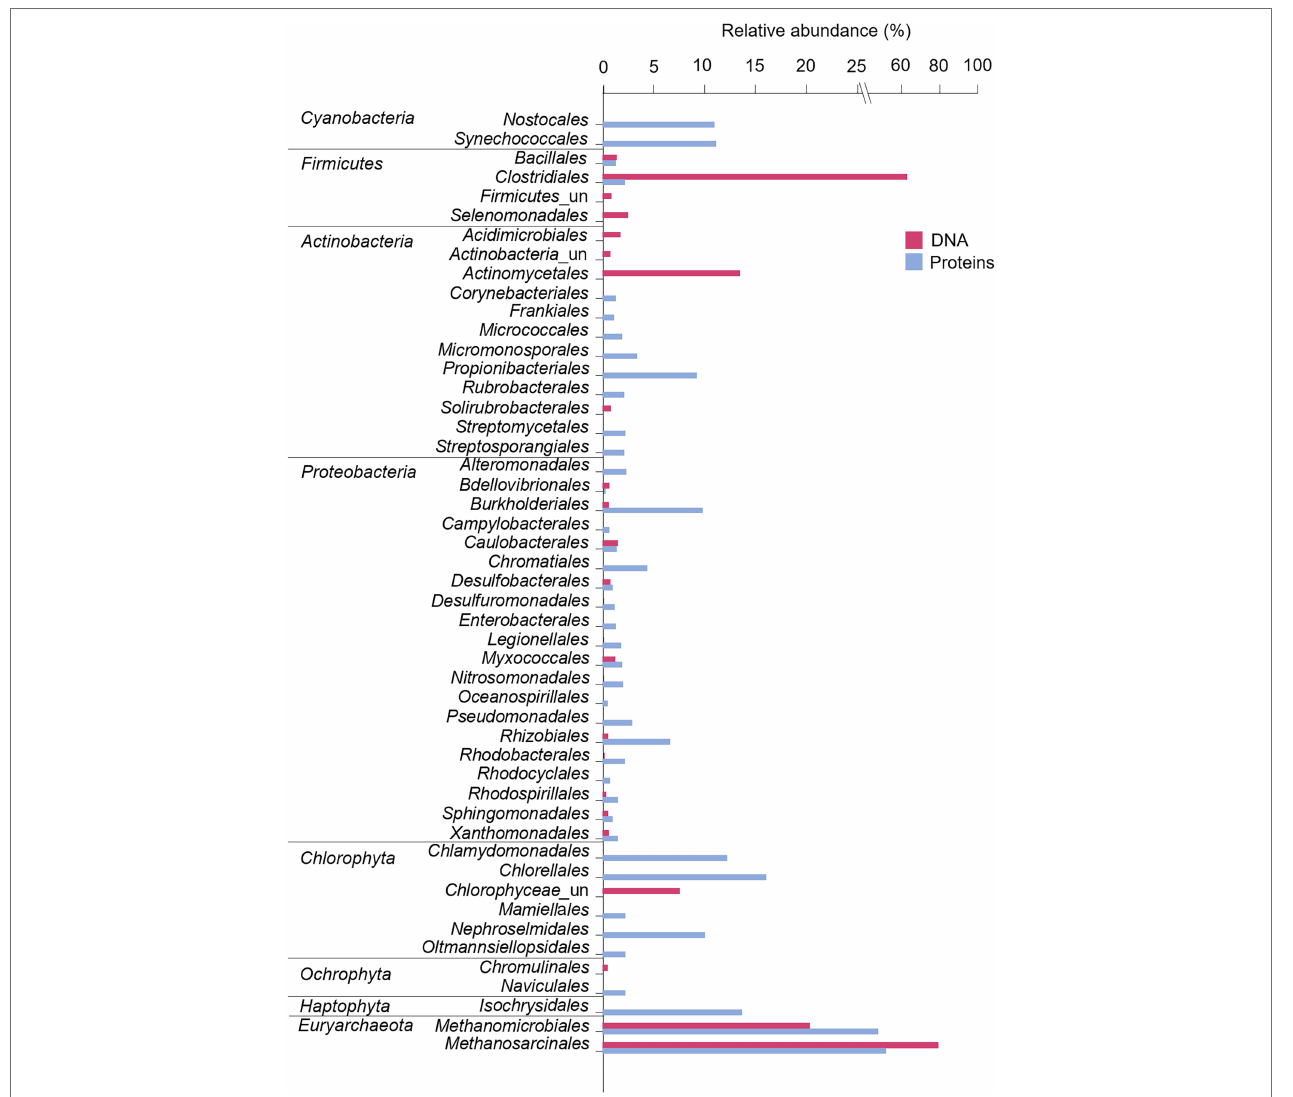
FIGURE 6 | Microbial composition and relative abundance of the most abundant orders (>0.5% over the bacterial, eukaryotic or archaeal community) within the dominant phyla in the microbial mat based on DNA and protein analyses. For Eukarya, only Chlorophyta , Ochrophyta , and Haptophyta were represented as some of the main photoautotrophs in fresh and marine ecosystems. Relative abundances (%) of proteins were calculated based on the NSAF relative to each domain (bacteria, archaea, or eukarya). “un” means